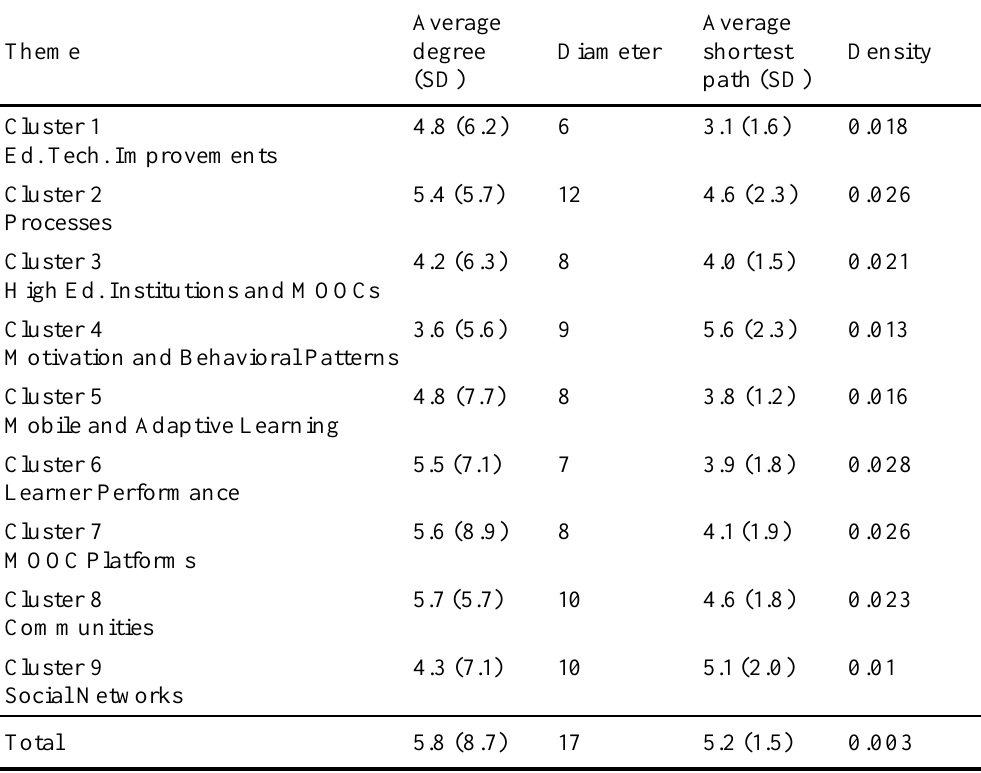
Phase 1 Citation Network